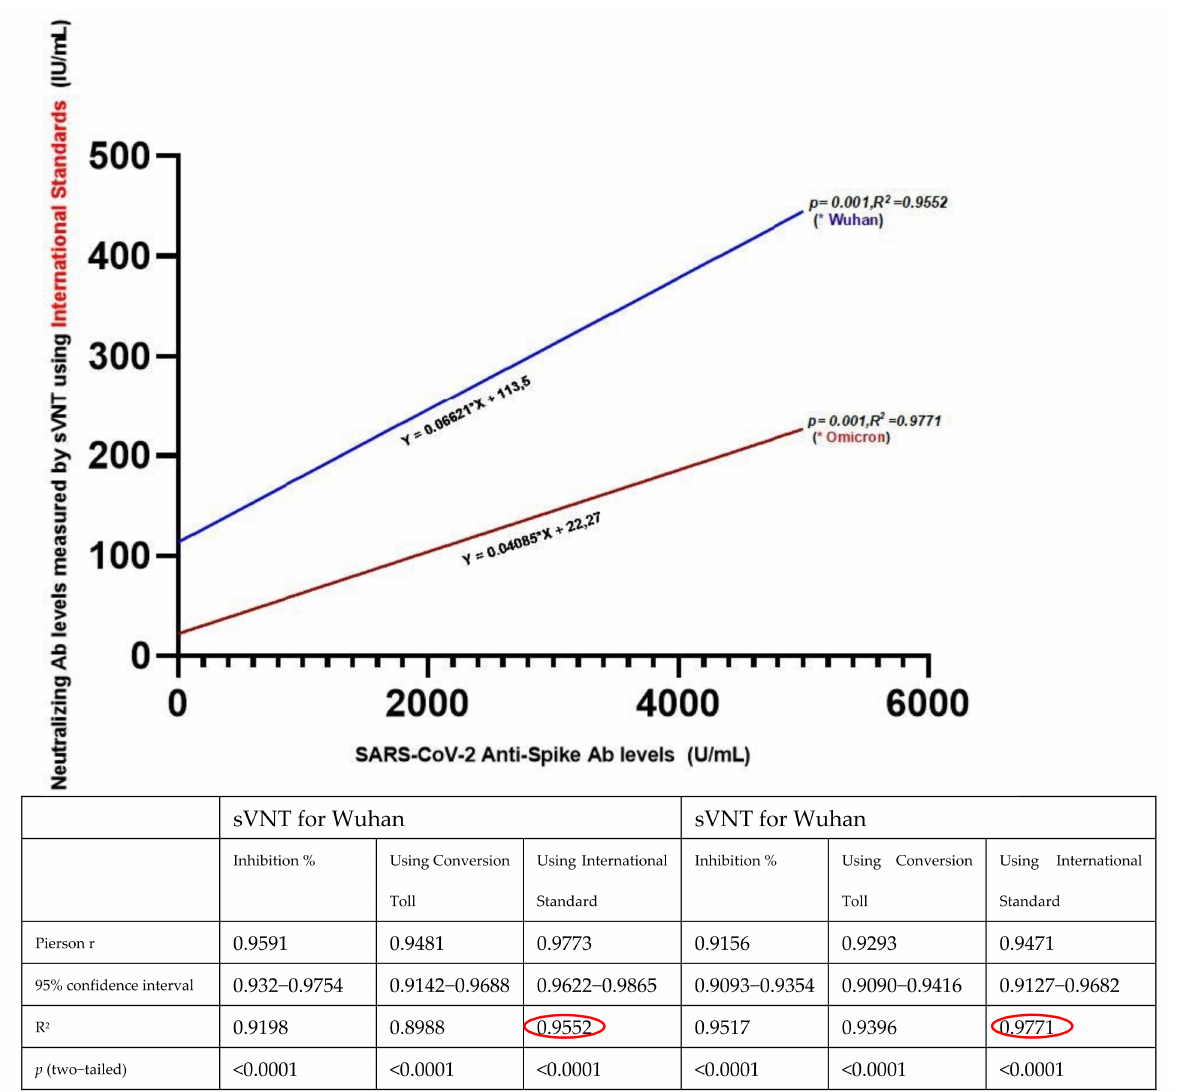
Figure 4. Strong correlation between anti–SARS–CoV–2 spike total Ab (ECLIA) and NAb levels (sVNT) for both Wuhan and Omicron variants, the highest value was obtained when using the international standard (shown in red on the figure). Pierson r, Confidence interval, R 2 , and p values of sVNT results obtained using the percentage of signal inhibition, conversion tool, and international standards. ( p < 0.05 and R 2 = 0.5–1 were considered statistically significant)